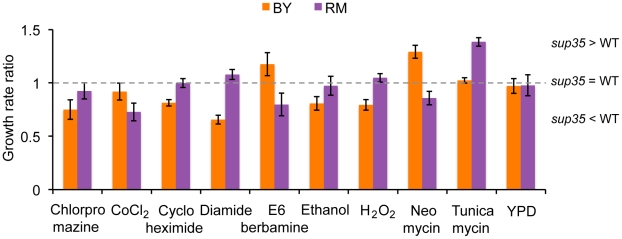
Readthrough-dependent strain-specific growth effects.The ratio of sup35 strain growth rate and wildtype strain growth rate is plotted (mean ± SD) for BY (orange bars) and RM (purple bars) for the nine conditions in which the effect of sup35C653R-mediated increase in readthrough on growth differed between the two strain backgrounds (uncorrected p<0.05, FDR∼10%).